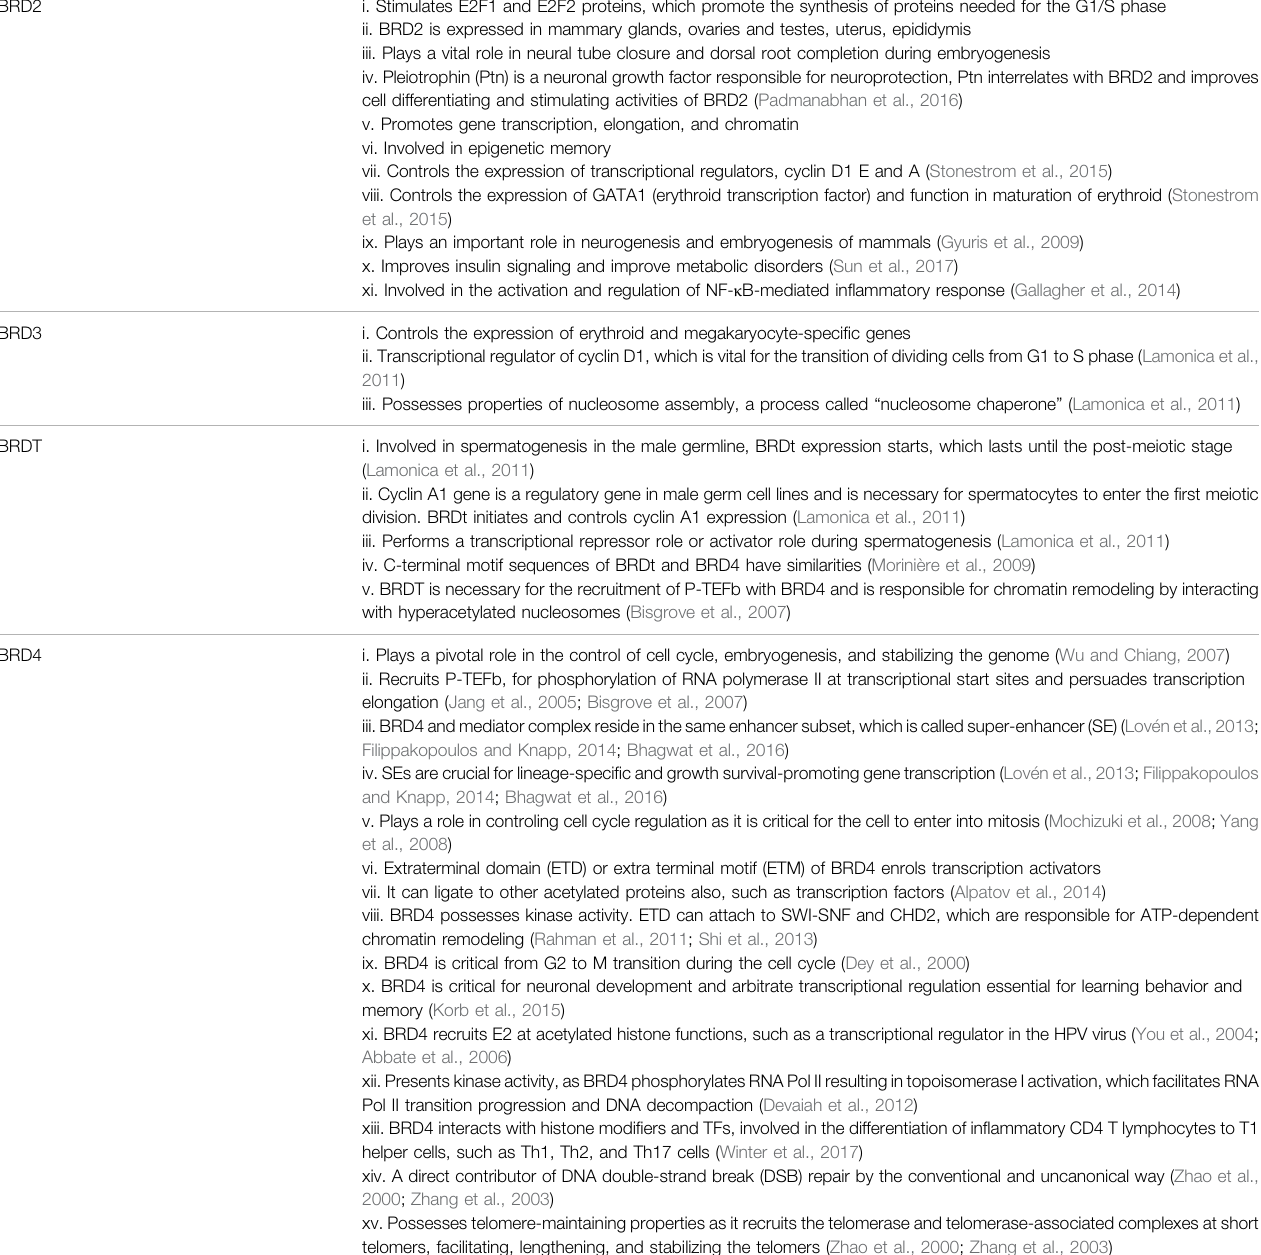
TABLE 2 | A summary of BET bromodomain protein physiological functions. BRD2 i. Stimulates E2F1 and E2F2 proteins, which promote the synthesis of proteins needed for the G1/S phase ii. BRD2 is expressed in mammary glands, ovaries and testes, uterus, epididymis iii. Plays a vital role in neural tube closure and dorsal root completion during embryogenesis iv. Pleiotrophin (Ptn) is a neuronal growth factor responsible for neuroprotection, Ptn interrelates with BRD2 and